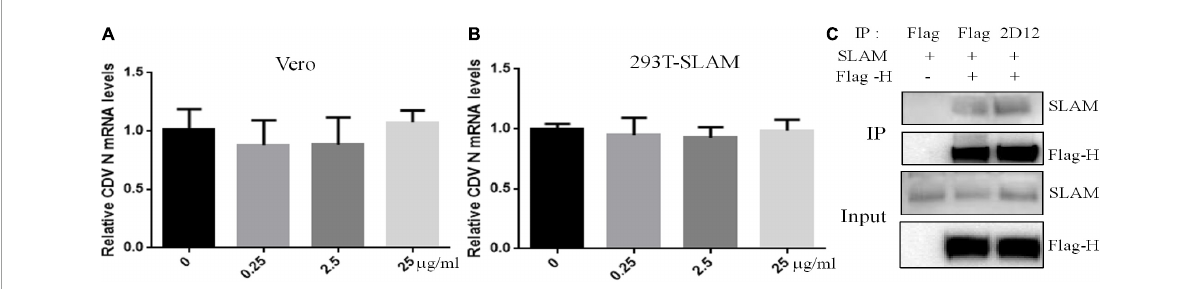
FIGURE5 Effect of mAb 2D12 on adsorption of canine distemper virus (CDV) to cells and the interaction between H protein and dogSLAM receptor. (A) The effect of mAb 2D12 on adsorption of CDV 851 to Vero cells was detect by RT-qPCR. CDV 851 and mAb 2D12 were mixed and inoculated into monolayer Vero cells. The N mRNA level of CDV adsorbing on the Vero cells was detected by RT-qPCR. (B) The effect of mAb 2D12 on adsorption of CDV 851 to 293T/SLAM cells was detect by RT-qPCR. CDV 851 and mAb 2D12 were mixed and inoculated into monolayer 293T/SLAM cells. The N mRNA level of CDV adsorbing on the 293T/dogSLAM cells was detected by RT-qPCR. Means ± S.D. of data from three independent experiments performed are shown. (C) The effect of mAb 2D12 on the interaction between Flag-H protein CDV 851 strain and dogSLAM by Co-IP assay. The Flag-H and dogSLAM proteins respectively expressed in 293T cells were immunoprecipitated with either mAb 2D12 or anti-Flag antibody, the precipitated Flag-H material was labeled with an anti-Flag antibody, and the coprecipitated dogSLAM protein was detected with an anti-SLAM antibody.